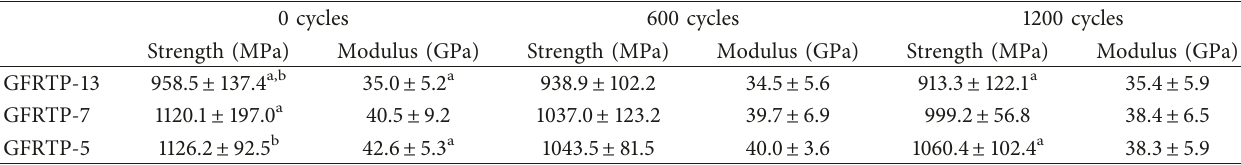
Table 4: Flexural properties of GFRTPs after thermocycling.